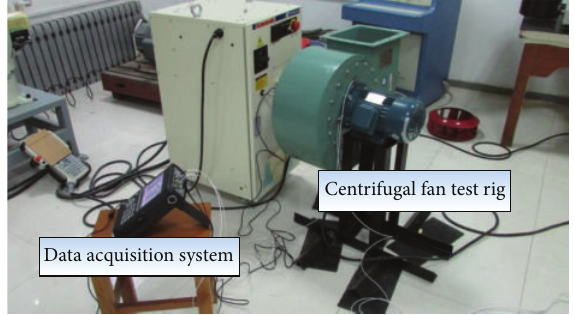
Figure 3: Centrifugal fan blade crack test